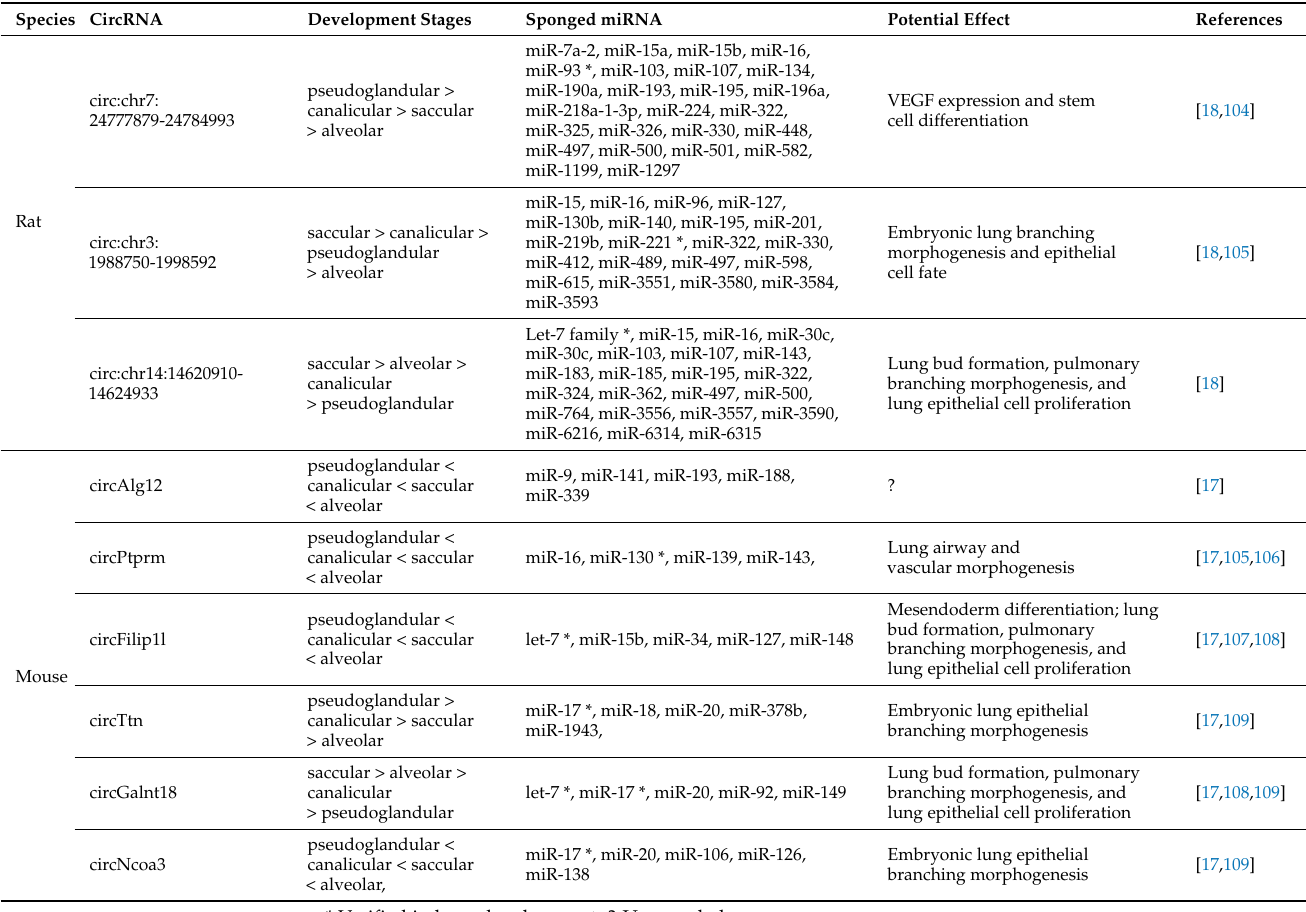
Table 1. CircRNAs-miRNA involved in lung development.